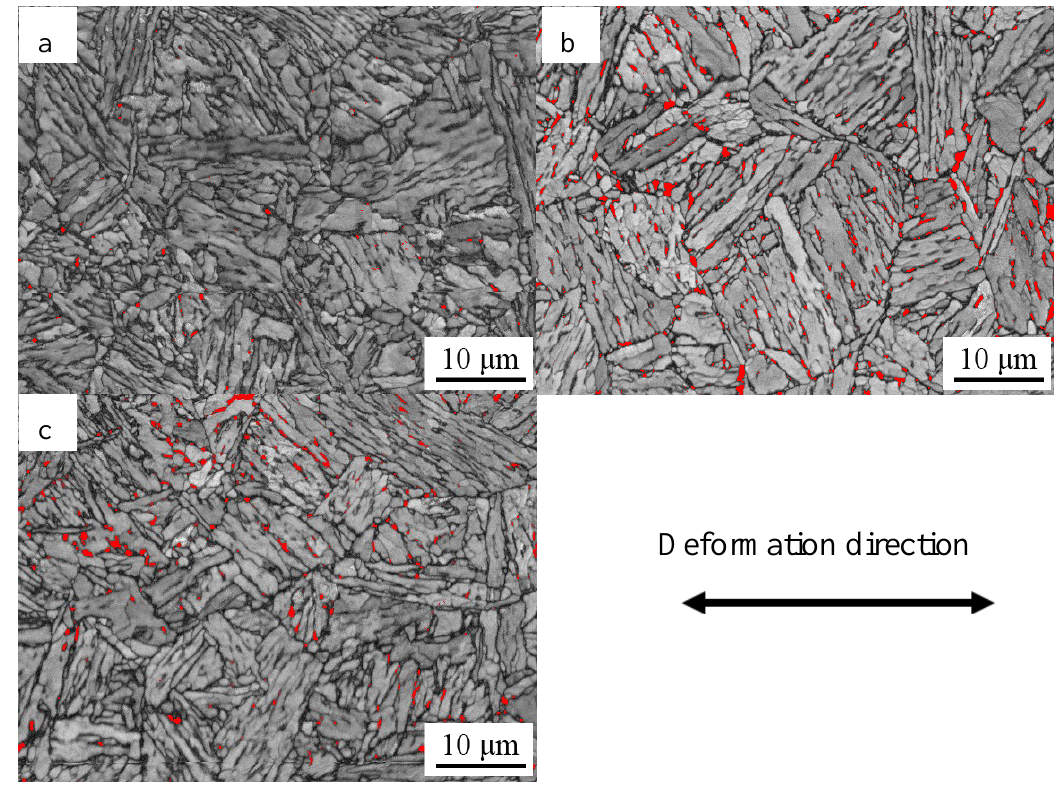
Figure 8. EBSD micrographs of retained austenite for samples tempered at 700 °C at different tensile strains: ( a ) strain ε = 2%, ( b ) strain ε = 5%, ( c ) strain ε = 10% (red corresponds to retained austenite).